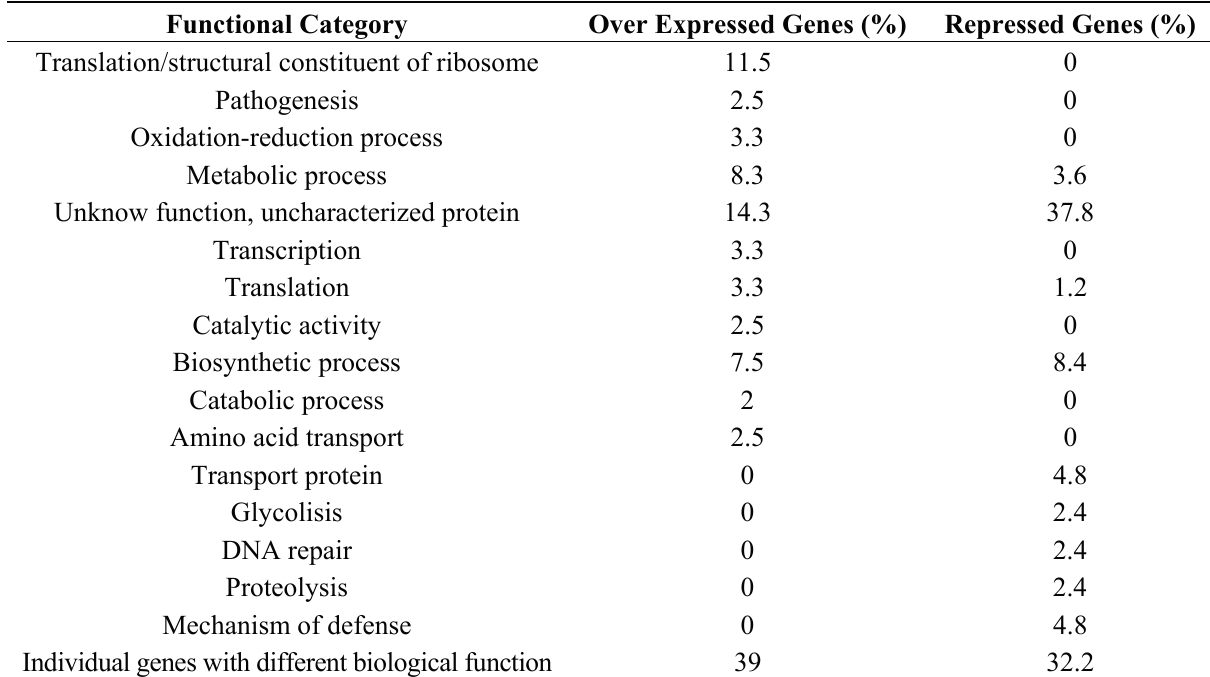
Table 1. Functional category of over expressed and repressed genes obtained from microarrays